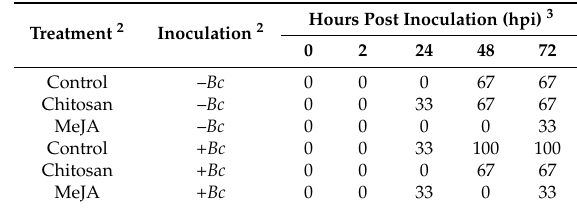
Table 1. Incidence (%) 1 of gray mold in the control-, chitosan-, and MeJA-treated Fragaria chiloensis fruit inoculated with (+ Bc ) or without (– Bc ) Botrytis cinerea spores during postharvest storage. Treatment 2 Inoculation